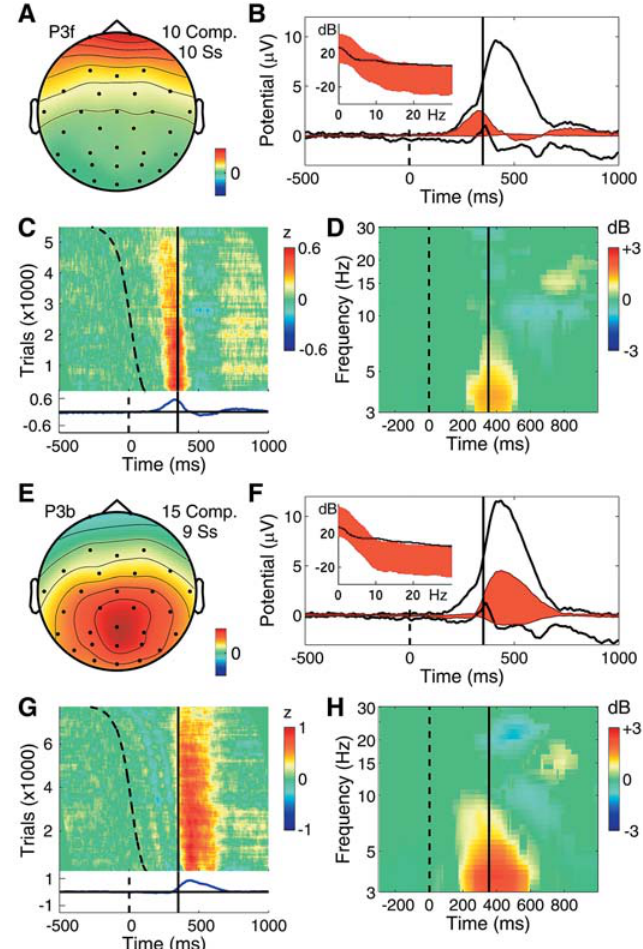
Figure 6. Far-Frontal and Parietal Component Clusters Contributing to the P300 (A–D) Far-frontal component cluster accounting for the preresponse (P3f) positivity. (E–H) Broad parietal component cluster accounting for part of the postresponse (P3b) positivity. The periresponse energy increase for these processes peaks at below 5 Hz. (A and E) The mean component scalp map. (B and F) The whole-data (black traces) and cluster-accounted (red fill) ERP envelopes (minimum and maximum voltage channel values at each time point), plus (inset) the power spectrum of the whole EEG (black traces) and the whole response-locked average ERP (red fill). The lower edge of the red fill shows actual ERP power, the upper edge, the phase-random EEG spectrum required to produce the observed average ERP spectrum by phase cancellation. The difference between the upper edge of the red fill and the actual EEG spectrum (black trace) reflects phase consistencies across trials in the single trial data. (C and G) ERP-image plot of the color-coded single trials time-locked to the response (solid vertical line) and sorted by RT from stimulus onset (dashed line). Trials normalized by dividing by the standard deviation of component activity in the 1-s prestimulus baseline. (D and H) The component mean ERSP showing mean event-related changes in (log) spectral power across data trials time-locked to the response (solid line). Here, median stimulus delivery time is indicated by the dashed